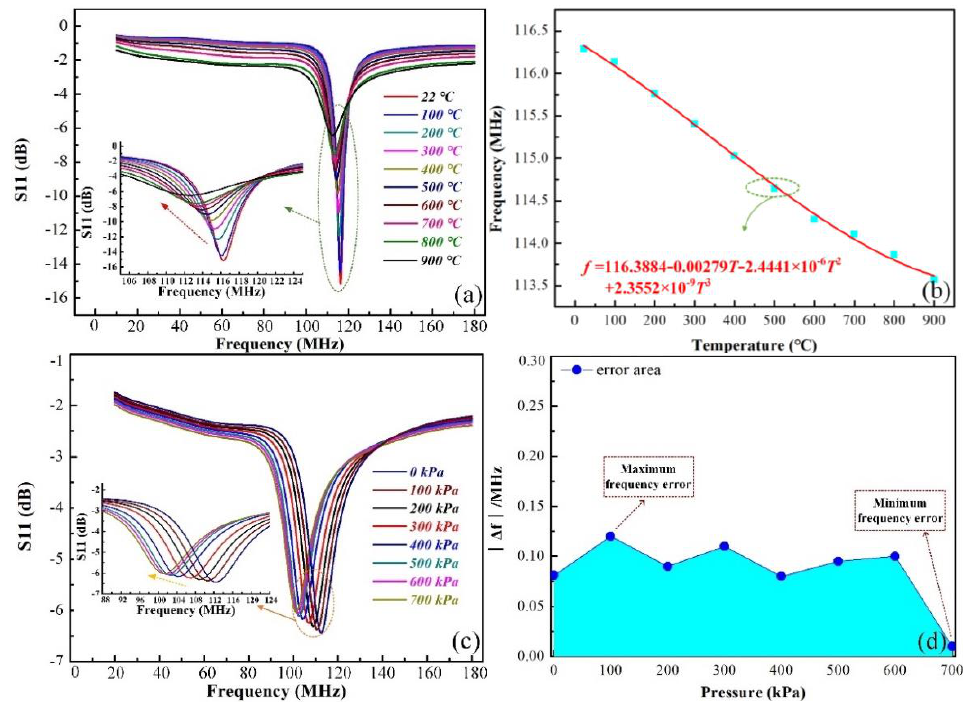
Figure 7. ( a ) The resonant frequency changes with the temperature under 0 kPa. ( b ) The zero drift of the sensor. ( c ) The pressure versus frequency from 0 kPa to 700 kPa at 900 °C. ( d ) The frequency error of the sensor at 900 °C.